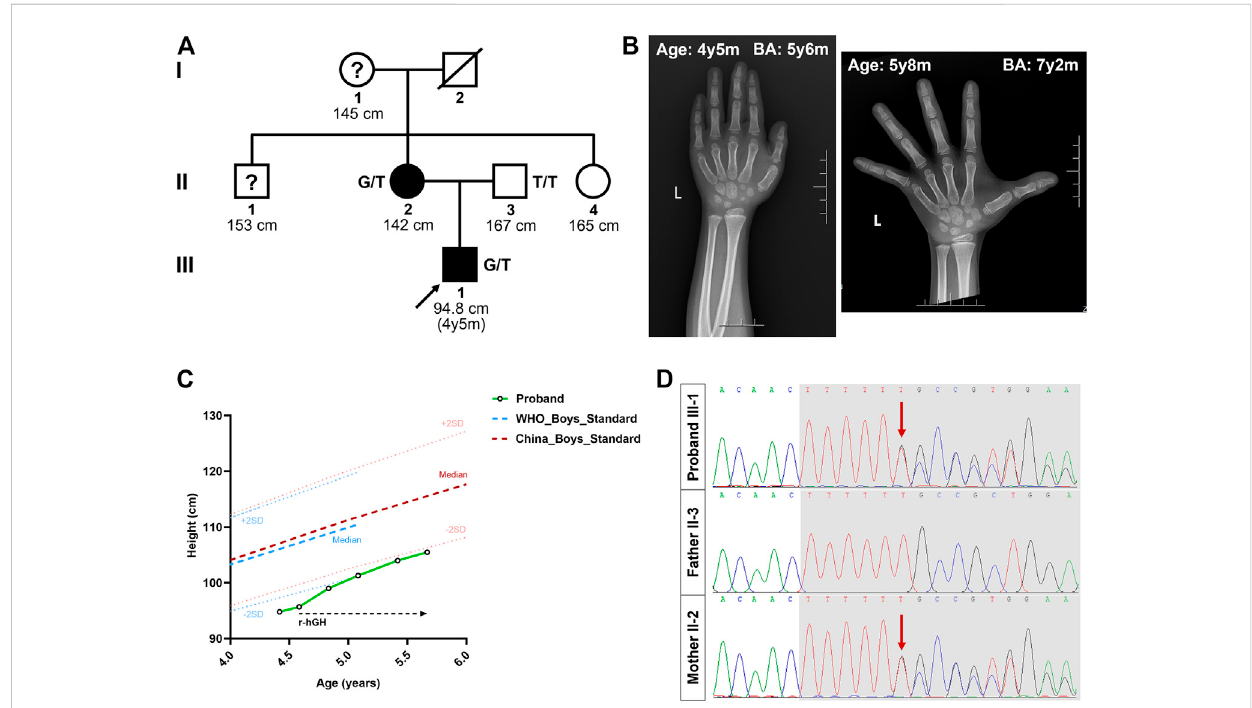
FIGURE 1 Pedigree of the Chinese family with short stature. (A) The black circles/squares represent the affected patients diagnosed with short stature diagnosis; the white circles/squares represent the unaffected subjects. The arrow indicates the proband. The question mark indicates subject with unknown genotype but known phenotype. (B) X-ray imagingoftheproband ’ slefthandattheageof4 years 5 monthsand 5 years8 months. (C) The height growthcurve ofthe probandduringtheone-yearfollow-up. (D) ThesequencingresultsoftheACANmutations.Sequencechromatogramsindicatetheheterozygosityfora ACAN frameshift mutation (NM_013227.3:c.7230delT; NP_001356197.1:p.Phe2410Leufs*9) in the proband and his mother. The red arrow indicates the mutation. SDS, standard deviation scores; r-hGH, Recombinant human growth hormone; y, year; m, month; BA, bone